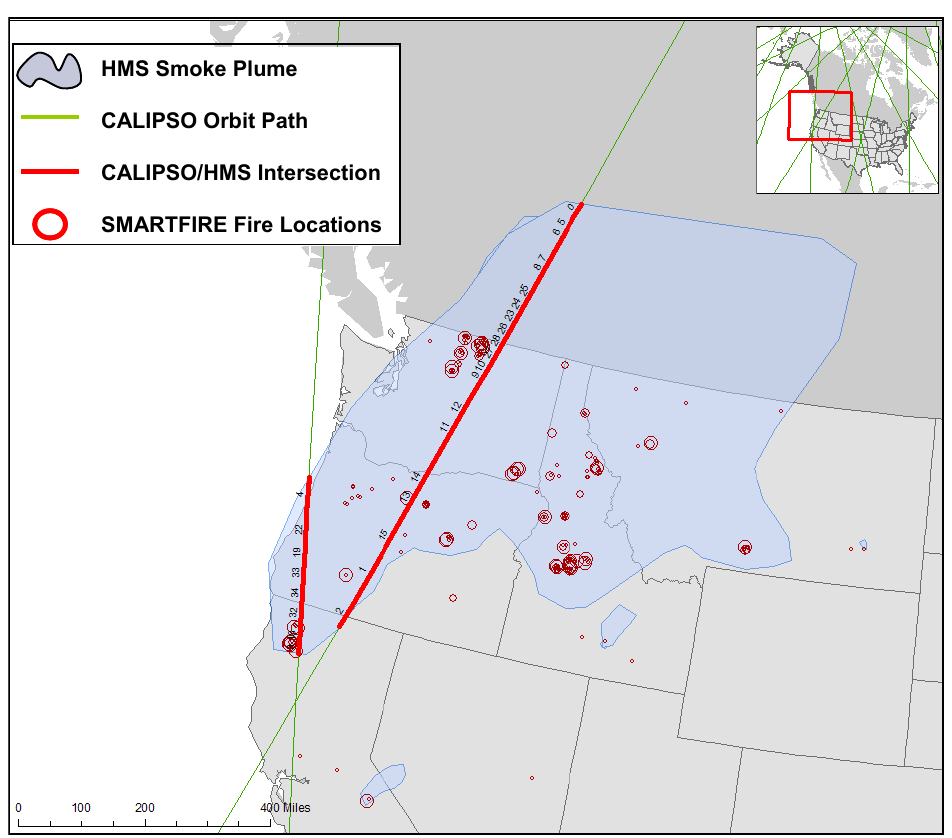
Figure 1. Example of the method for identifying days and times when the CALIPSO orbit path intersected an HMS smoke plume. The HMS smoke plume data are indicated by blue shading, the CALIPSO orbit paths are shown as green lines, and red circles are the SMARTFIRE fire locations. Red lines indicate times when the CALIPSO orbit path intersected the HMS smoke